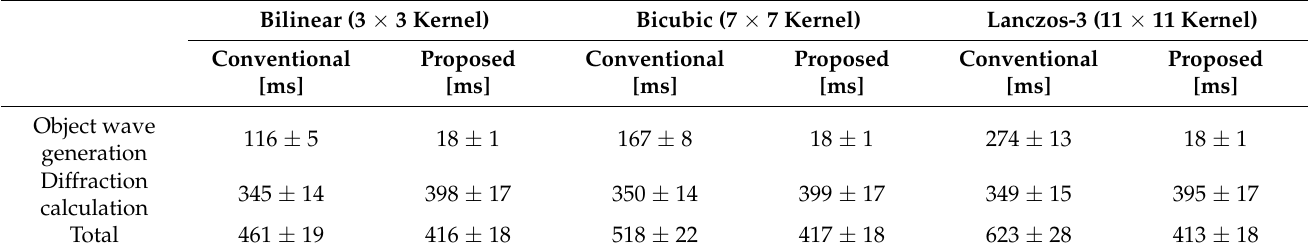
Table 1. Calculation time for the conventional and proposed